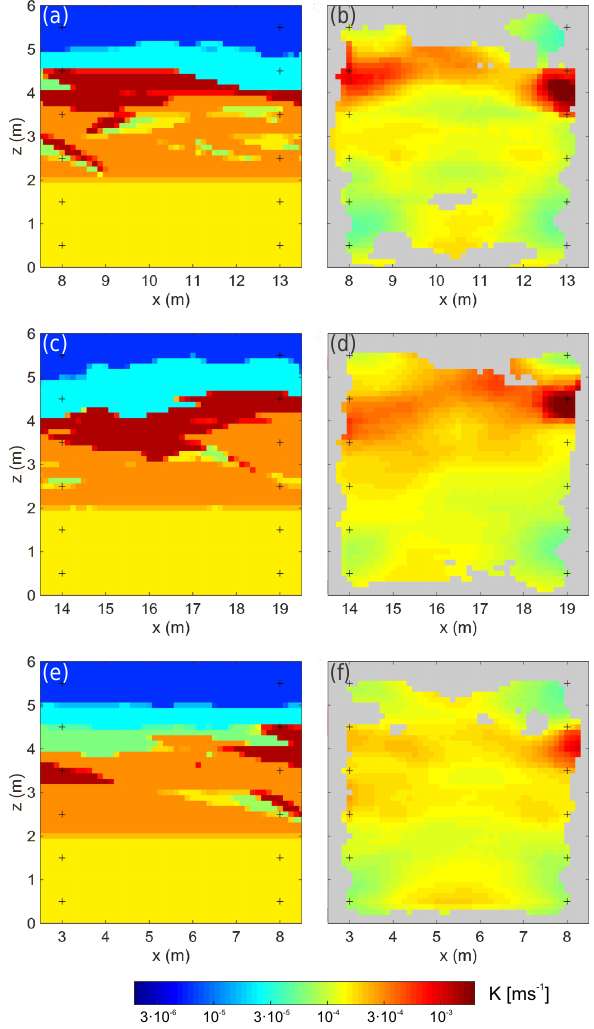
Figure 5. Hydraulic conductivity profiles (see Fig. 3): (a) profile 1 – aquifer analog; (b) profile 1 – reconstructed tomogram; (c) profile 2 – aquifer analog; (d) profile 2 – reconstructed tomogram; (e) pro- file 3 – aquifer analog; and (f) profile 3 – reconstructed